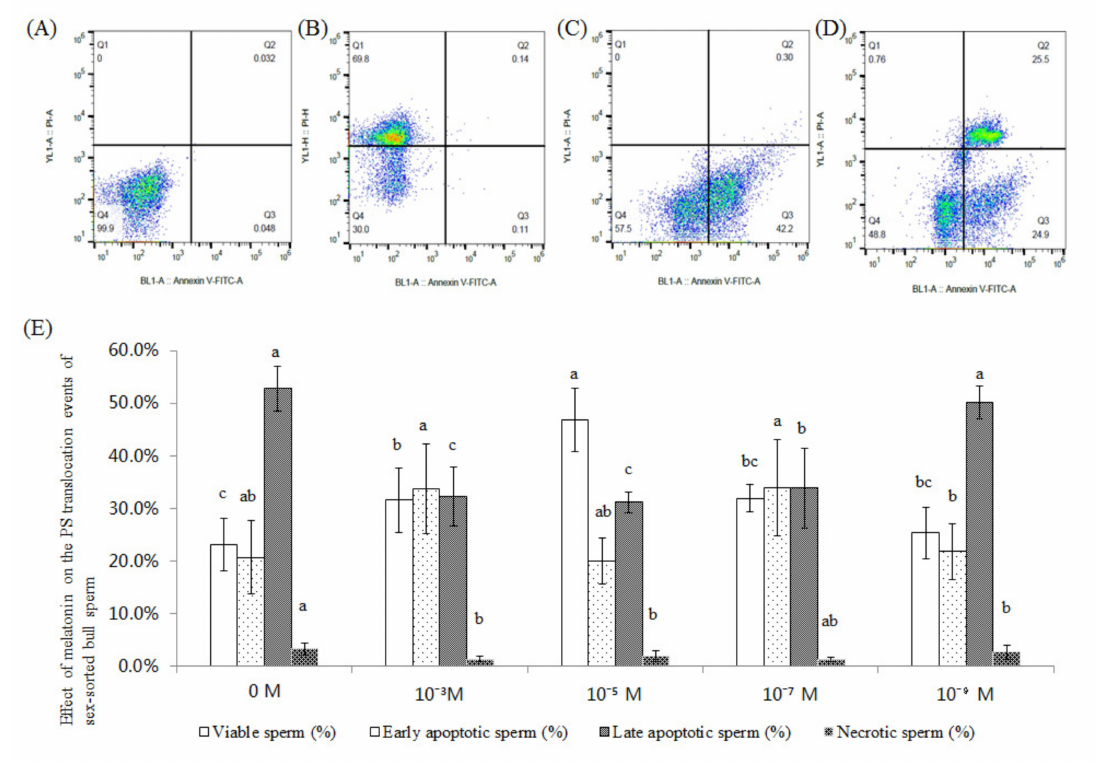
Figure 2. E ff ect of melatonin on the PS externalization events of sex-sorted bull sperm. ( A ) Negative control. ( B ) PI staining control. ( C ) Annexin V FITC staining control. ( D ) Analysis of sex-sorted bull sperm. Quadrants represented viable sperm (lower-left quadrant), early apoptotic sperm (lower-right quadrant), early necrotic sperm (upper-right quadrant), and necrotic sperm (upper-left quadrant). ( E ) E ff ect of melatonin on the PS externalization events of sex-sorted bull sperm. Lowercase letters represent statistical significant di ff erence ( p <